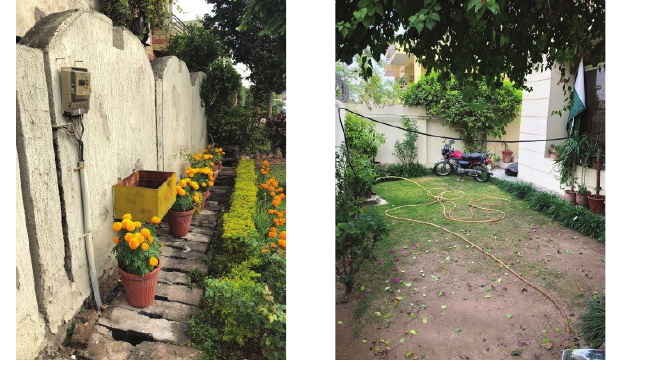
Figure 11. Garbage lying in the lobbies of apartment